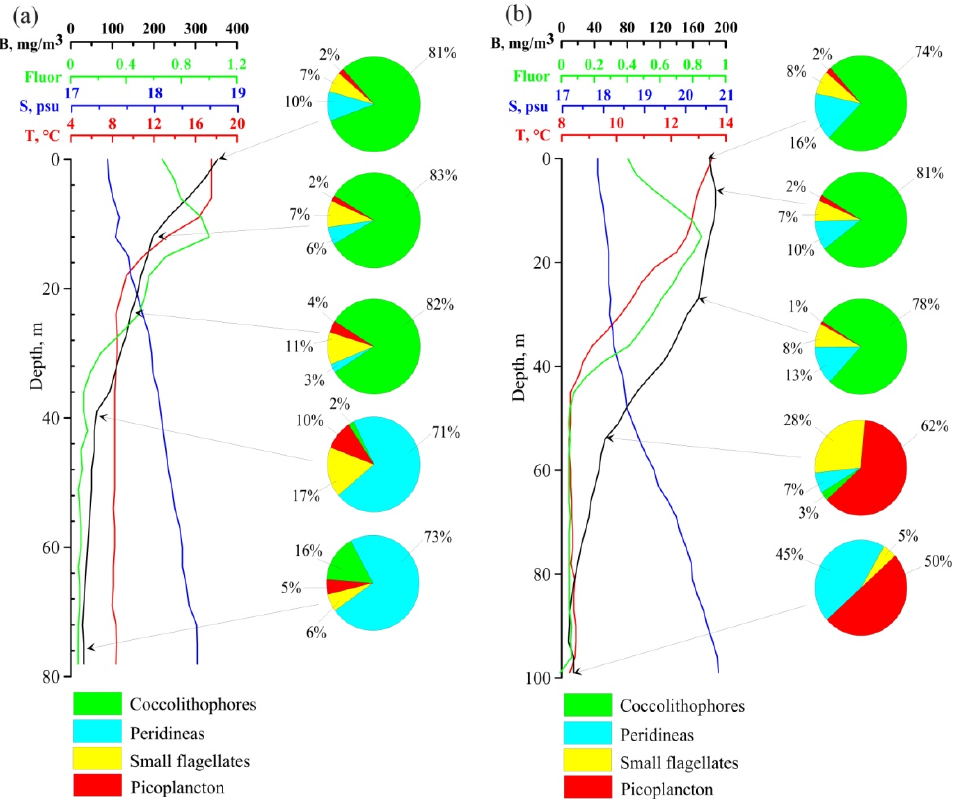
Figure 16. Vertical distribution of temperature (T), salinity (S), fluorescence (Fluo), total biomass (B) and phytoplankton structure during the summer and winter growing season in the north-eastern part of the Black Sea; ( a )—June 2011; ( b )—December 2010.